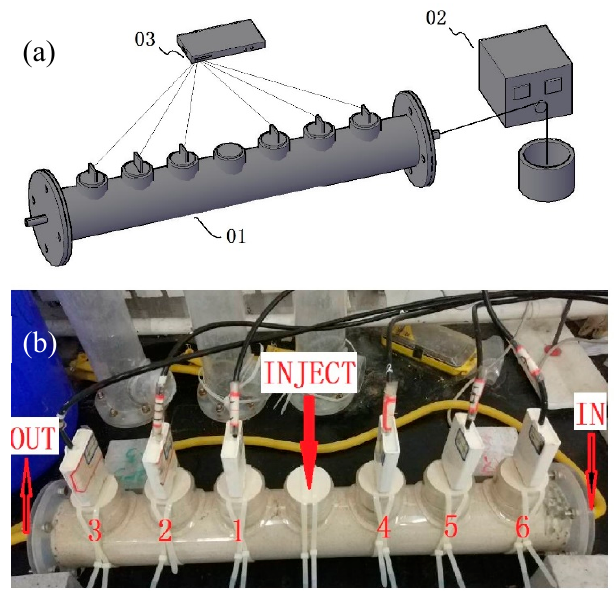
Figure 6. Molecular di ff usion and mechanical dispersion test device. ( a ) Schematic Diagram ( b ) Real Product (01: dispersion body, 02: water supply part, 03: data acquisition system).